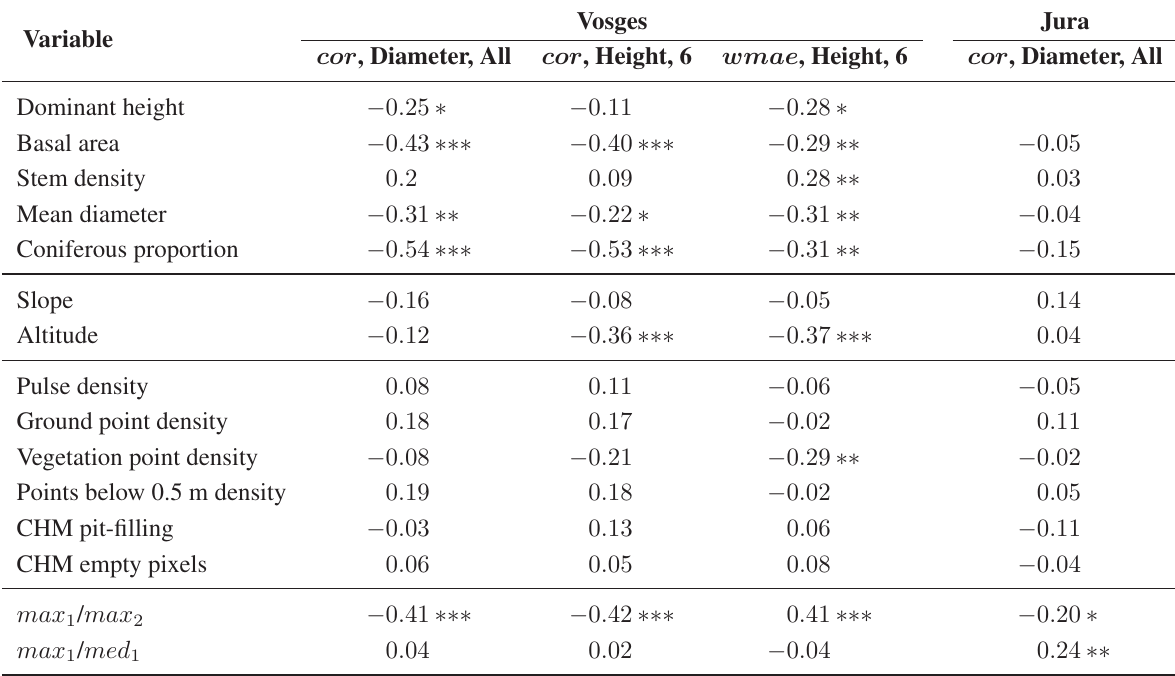
Table 3. Spearman correlation coefficient ρ between forest, topographic, airborne laser scanning (ALS) and co-registration variables and co-registration error (the distance between the operator and algorithm positions for the validated plots) for different algorithm